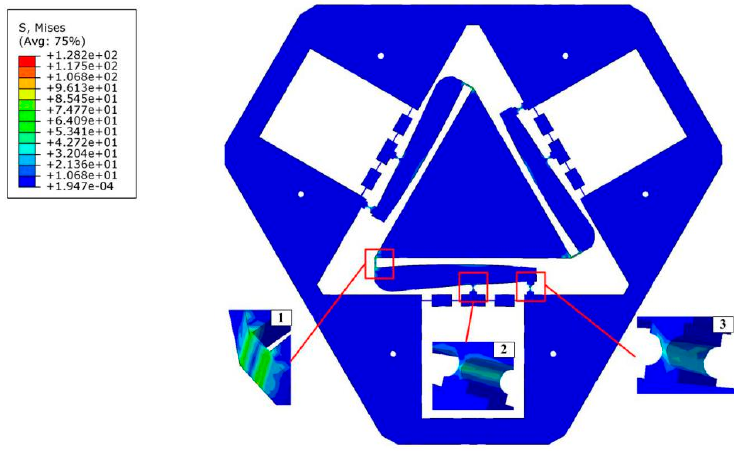
Figure 14. Stress simulation of the VPD.